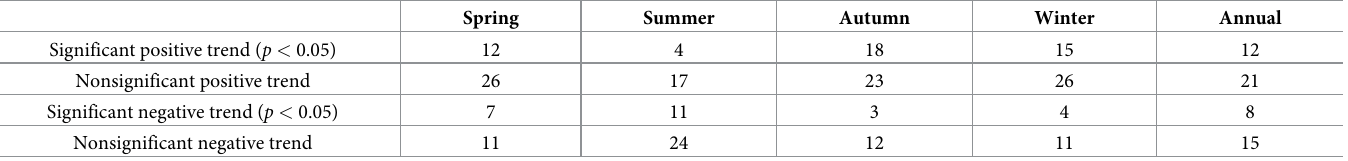
Table 2. Numbers of stations with different trends of potential evapotranspiration by season. Spring Summer Autumn Winter Annual Significant positive trend ( p <